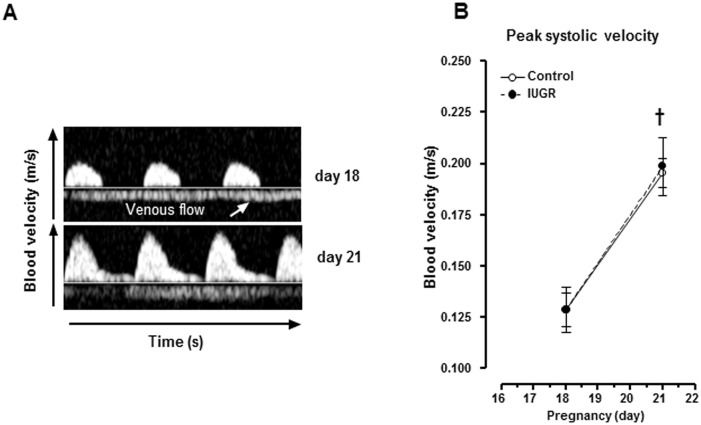
Umbilical circulation in control and IUGR animals.(A) Doppler velocity waveforms recorded from the umbilical cord of a control fetus on day 18 and 21 of gestation. (B) Peak systolic velocity in umbilical cord. Results are expressed as means ± SEM from 8 fetuses/group. † P<0.05, two-way ANOVA, effect of gestational day.